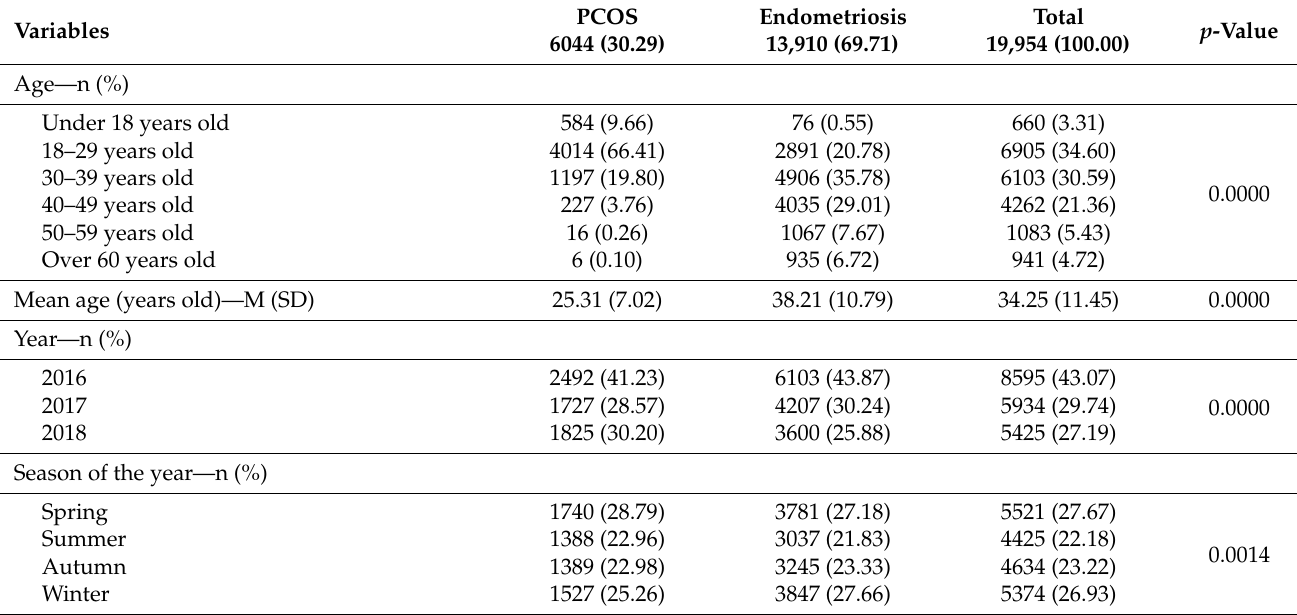
Table 1. Characteristics and analysis of the age of women and Outpatient Specialist Care (AOS) care in patients with diagnosed endometriosis or polycystic ovary syndrome